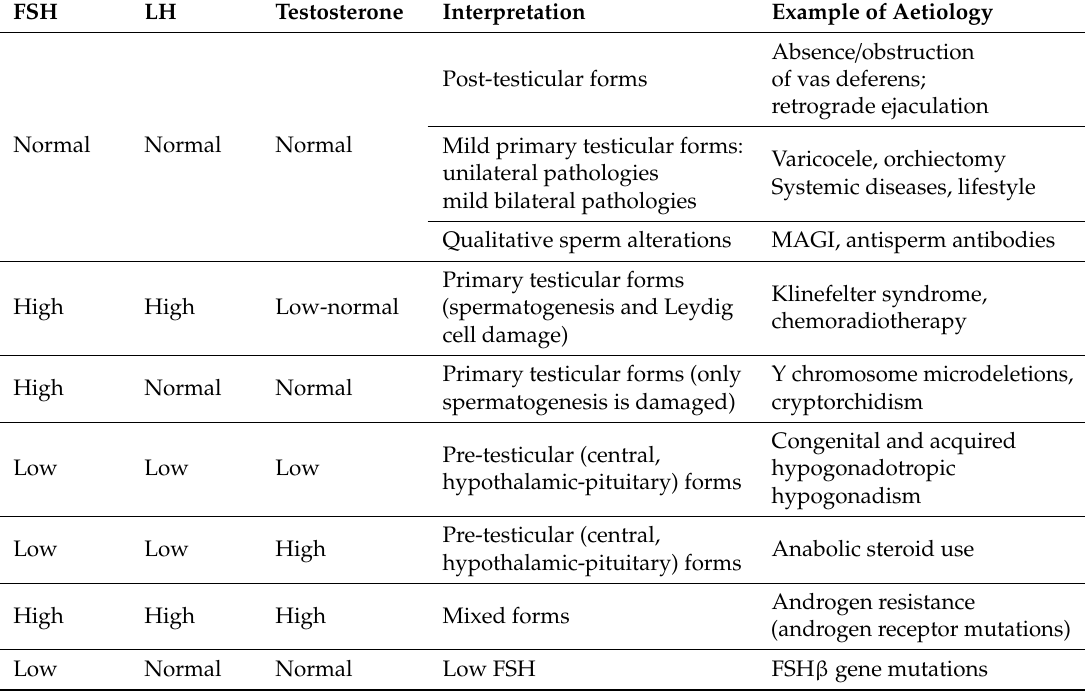
Table 6. Significance of hormonal levels in infertile men with quantitative and / or qualitative semen alterations. FSH: follicle stimulating hormone, LH: luteinizing hormone, MAGI: male accessory gland